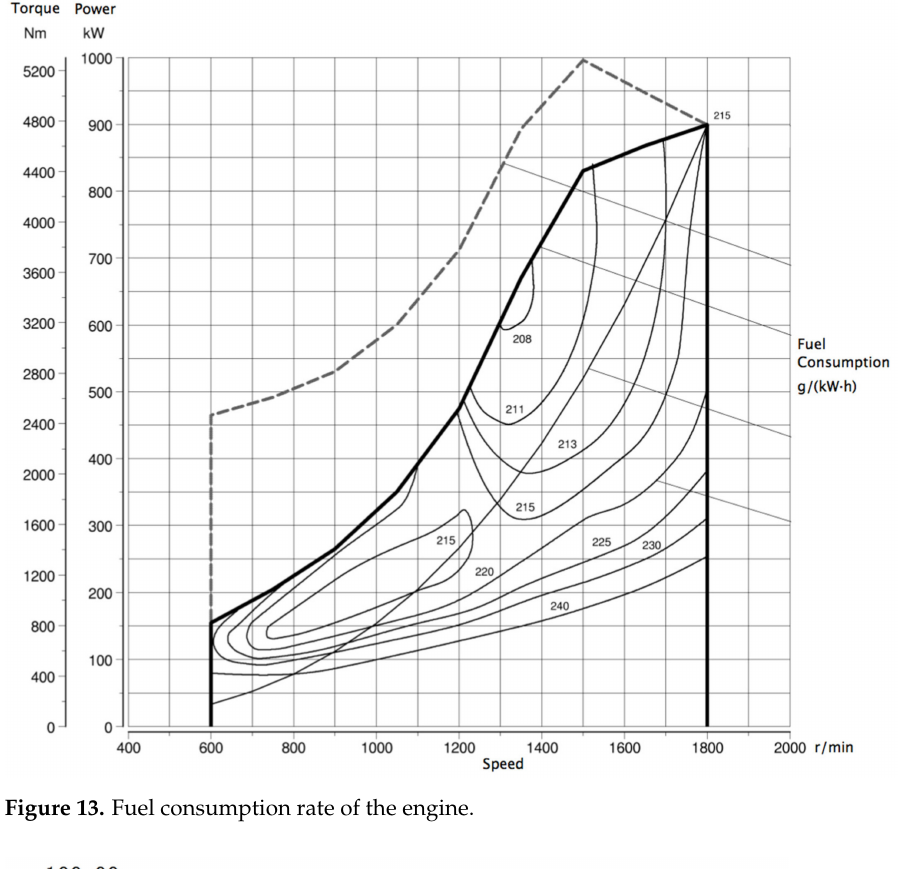
Figure 13. Fuel consumption rate of the engine.